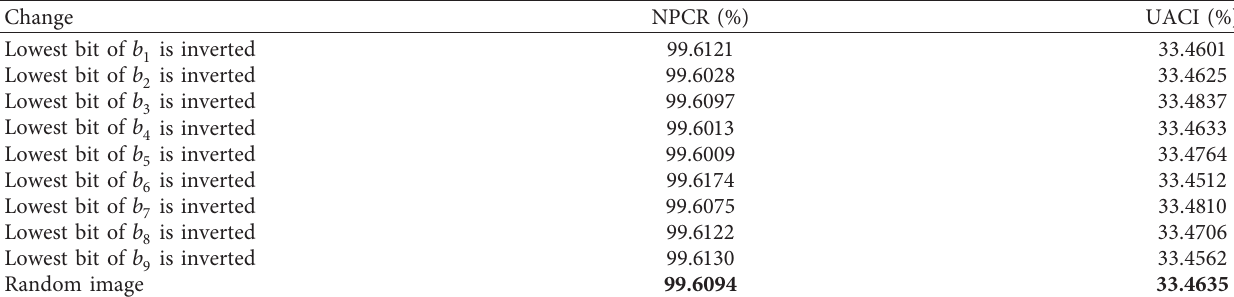
Figure 9: Key sensitivity test for decryption process: (a) ˇC obtained by K R ; (b) decrypted image ˇC R ˇC ( 1 ) ˇC ( 2 ) K ( 1 ) K ( 2 ) R ; (d) decrypted image R ; (e) difference image between R obtained by R obtained by Table 4: UPCR and UACI values between cipher images when secret key